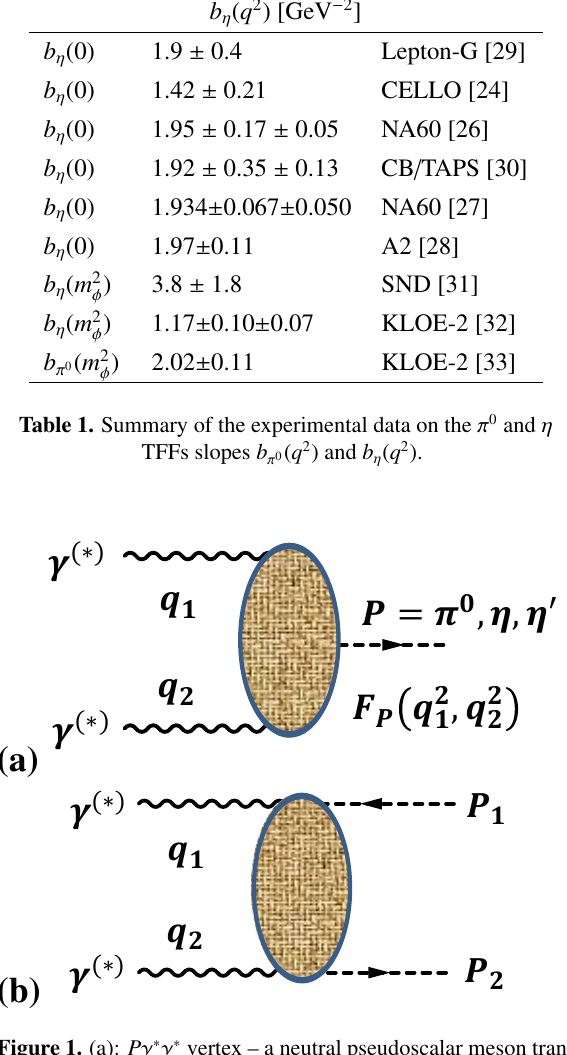
Table. 1. The first observation of η (cid:48) → γ e + e − was reported by BESIII